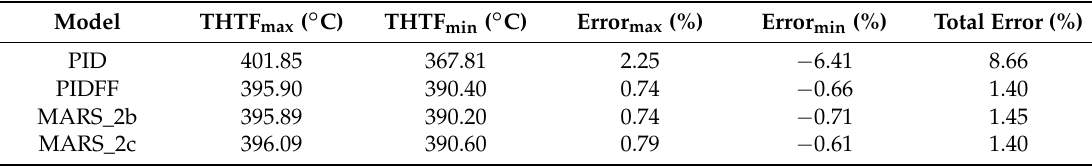
Figure 7. Comparison between MARS models and real input data—April 2011. Table 6. Controllers’ responses to real solar field (SF) data (April 2011). PID: proportional–integral– derivative; PIDFF: PID with feed-forward.